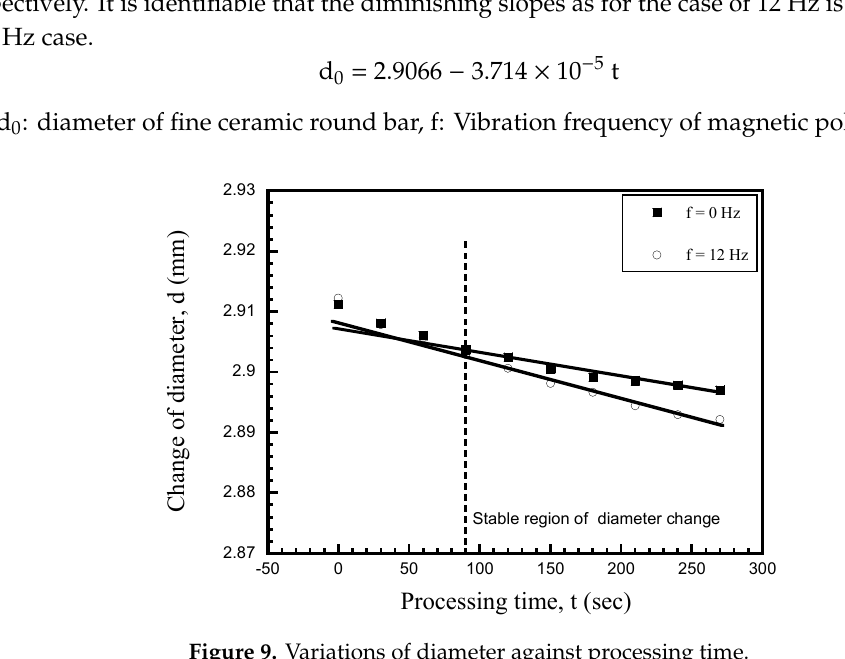
Figure 9. Variations of diameter against processing time.